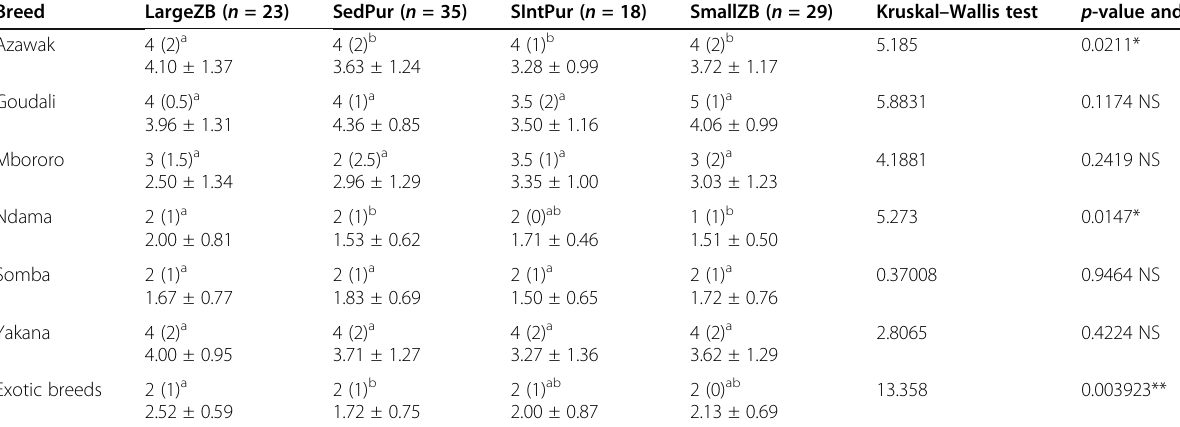
Table 1 Threat level from the other cattle breeds according to groups of farmers Breed LargeZB ( n = 23) SedPur ( n = 35) SIntPur ( n = 18) Kruskal – Wallis test